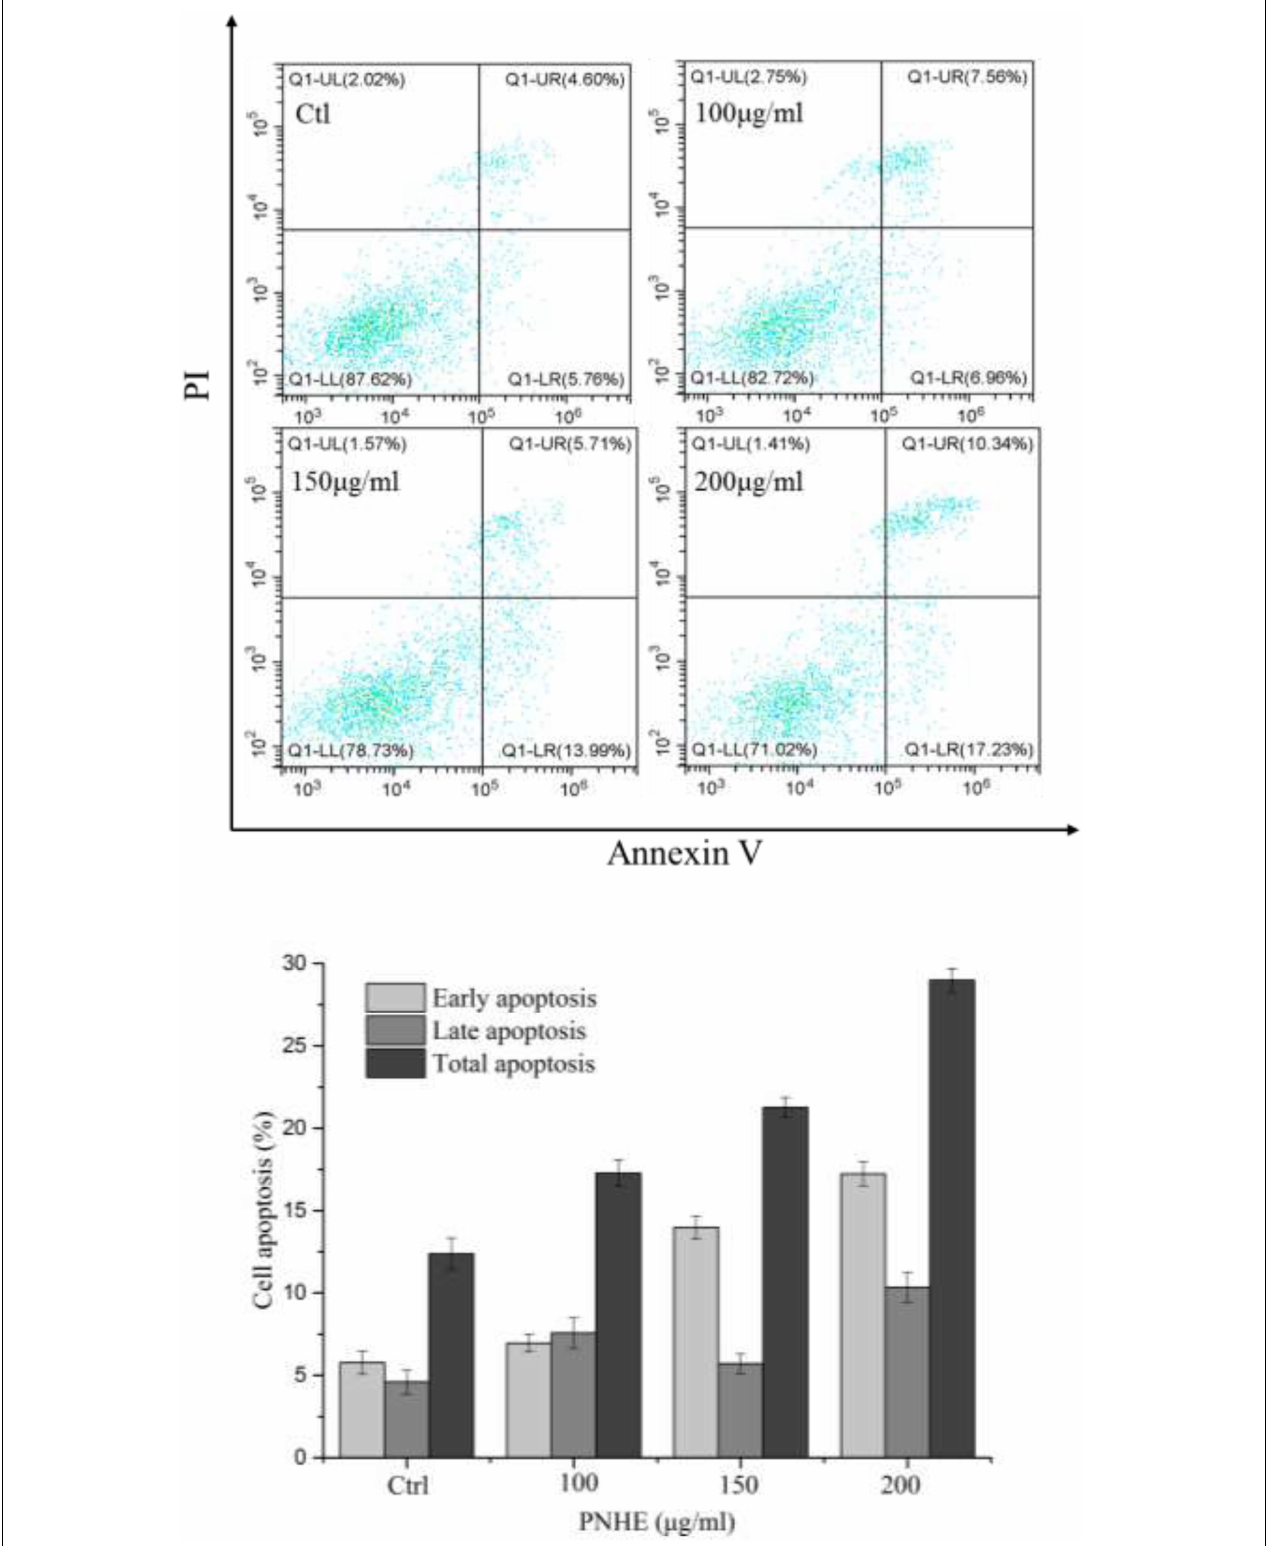
FIGURE 7 | The pro-apoptotic effect of PNHE on MCF-7 cells as observed by double-staining with annexin V and PI and flow cytometry. Data are expressed as a percentage of all cells, and are represented and mean ± standard deviation ( n = 3).